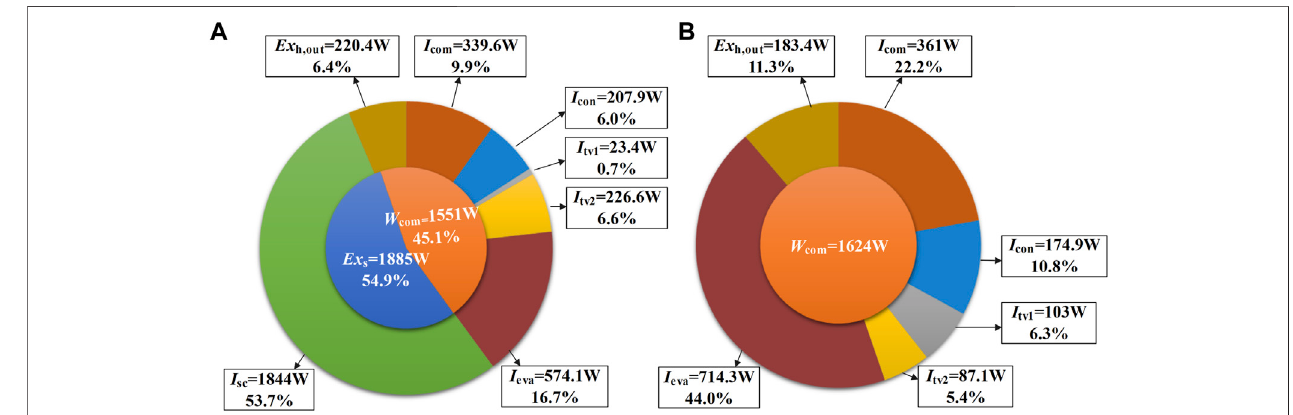
FIGURE 11 | Exergy fl ow diagrams for the DS-VIHP system (A) and the FVHP system (B) .